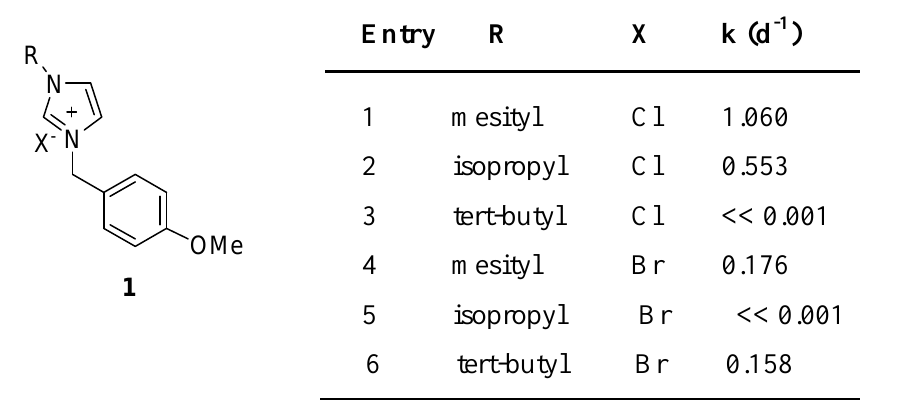
containing 3% water at 300 4